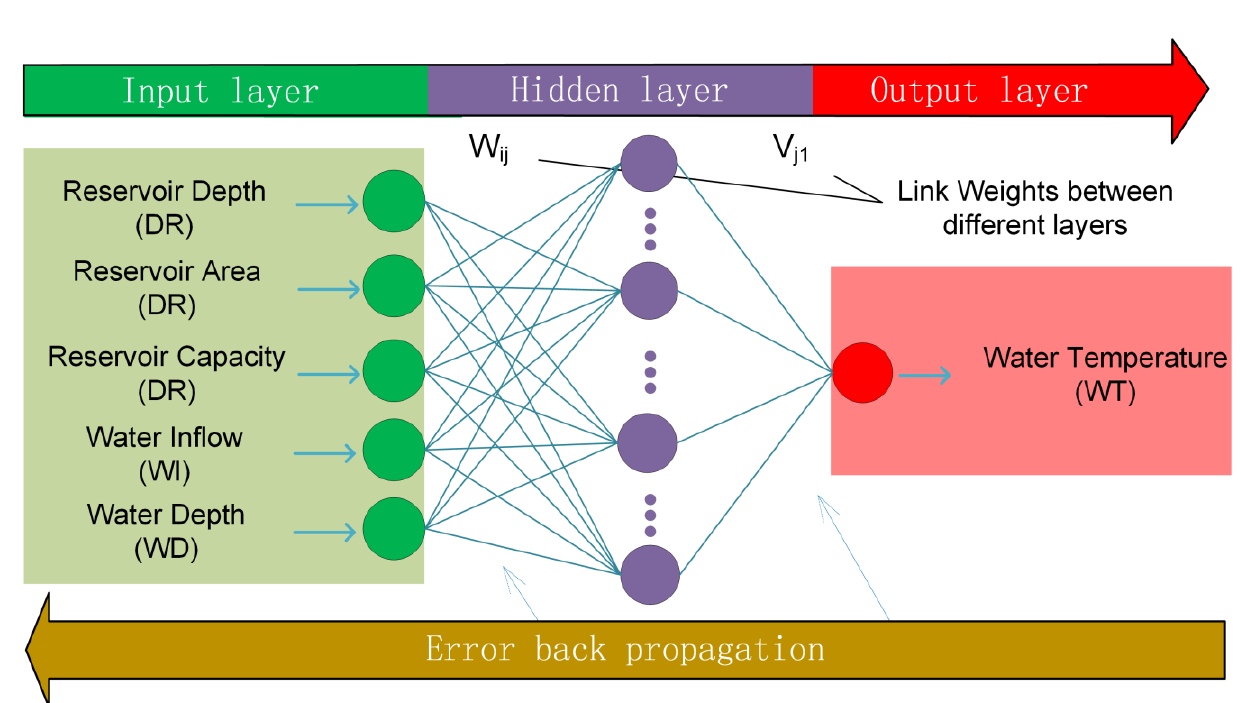
Figure 5. The topological structure of